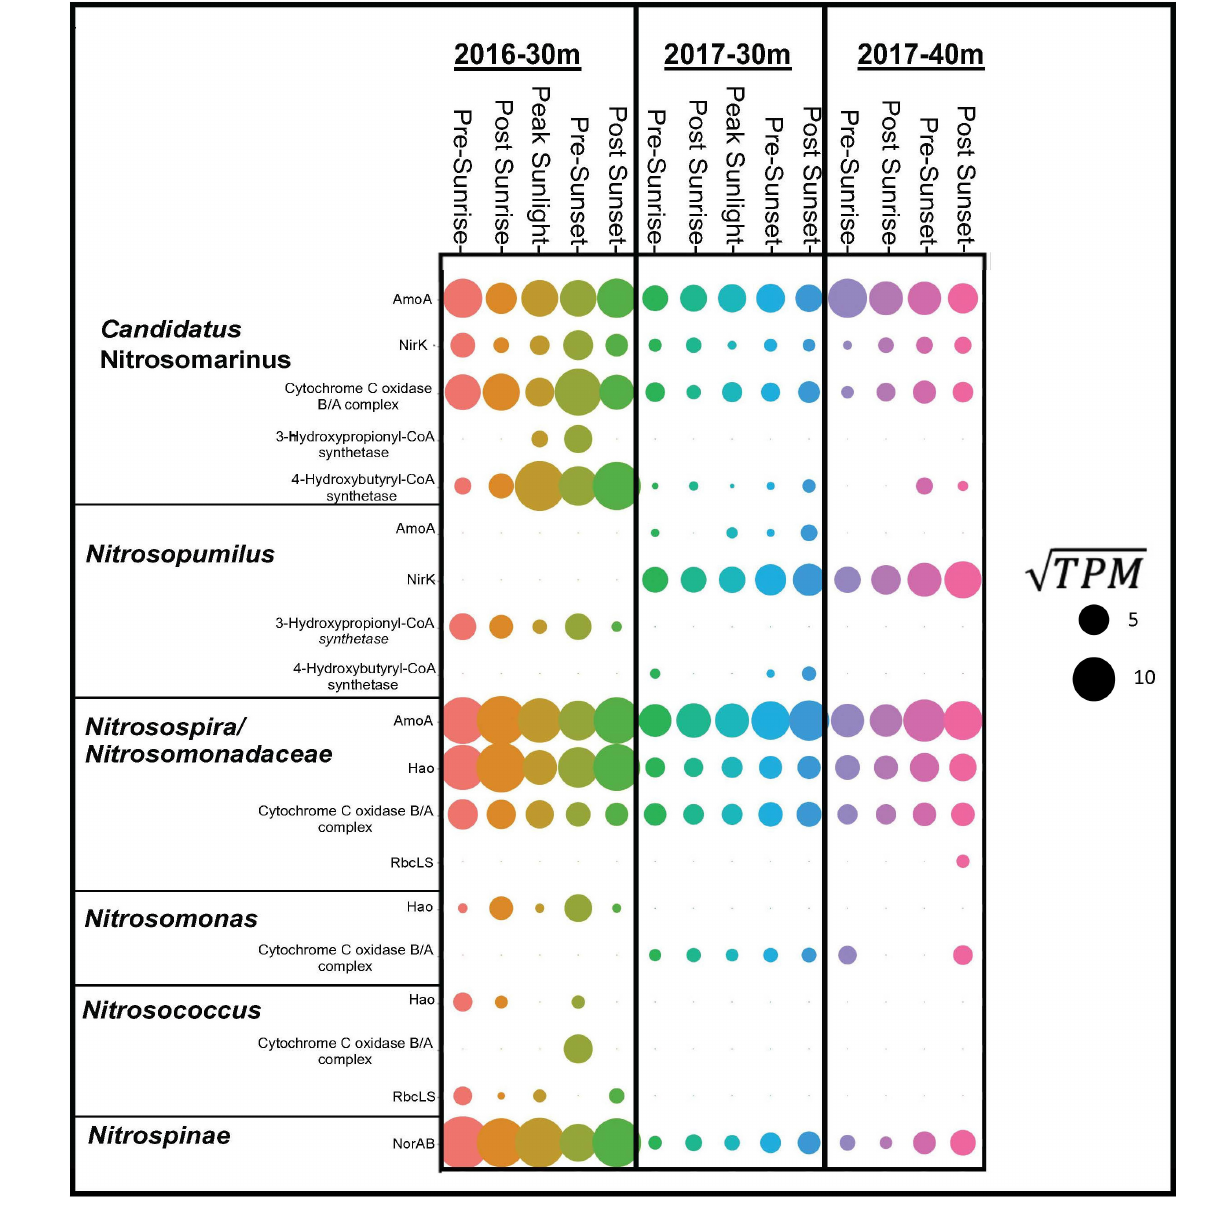
FIGURE 5 | Dot plot showing gene expression in ln(TPM) for dominate taxa ( Candidatus Nitrosomarinus, Nitrsopumilus, Nitrosospira, Nitrosomondaceae bacteria, Nitrosomonas, Nitrosococcus, and Nitrospinae ) for gene products associated with nitrification, carbon fixation and aerobic respiration in euphotic layers of both